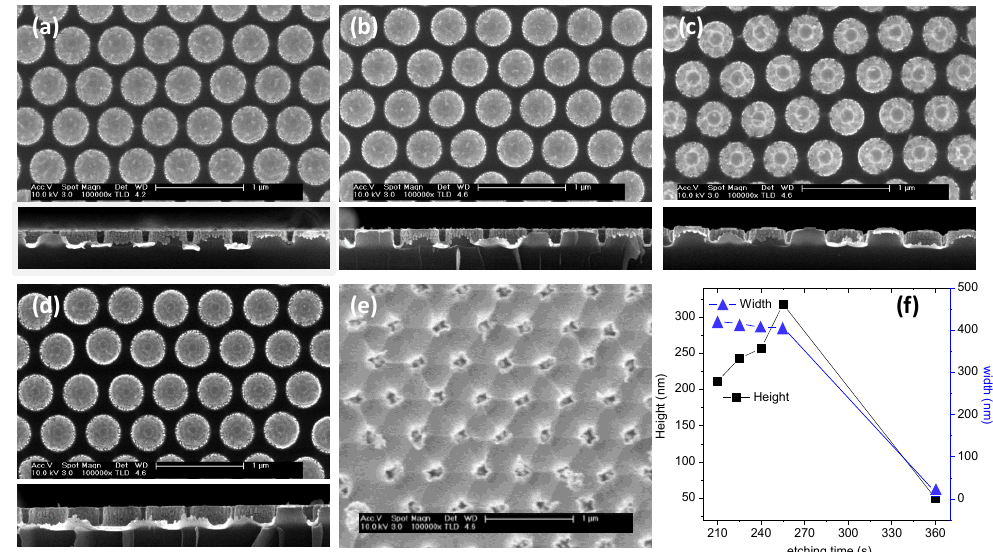
Figure 2. FESEM images of the Si pillar structures obtained after RIE processing during 210, 225, 240, 255, and 360 s ( a – e , respectively) and corresponding cross section view (bottom, except for e ) obtained after Au deposition to refine image acquisition. f ) Plot of the evolution of height and width of the Si pillars as derived from the FESEM images.